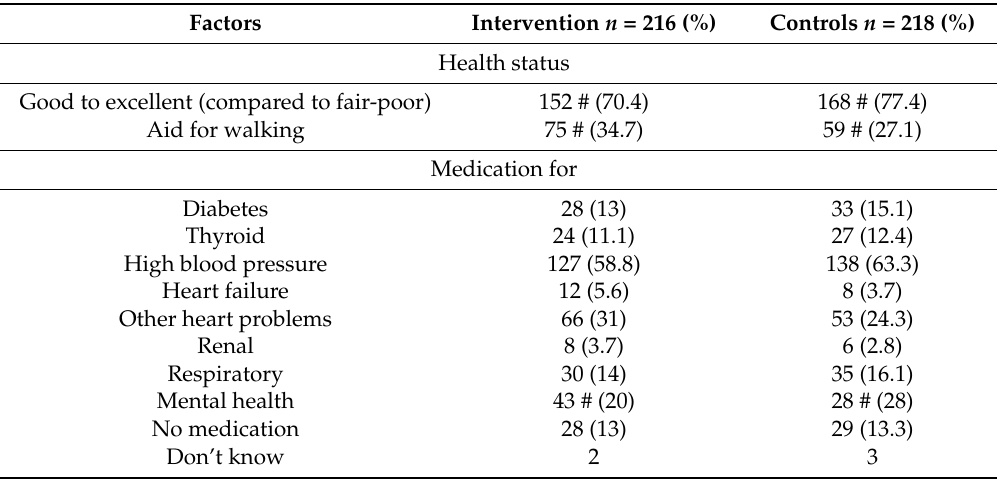
Table 2. Assessment of the frequency distribution of possible confounding variables indicating pre-existing chronic disease by intervention and control